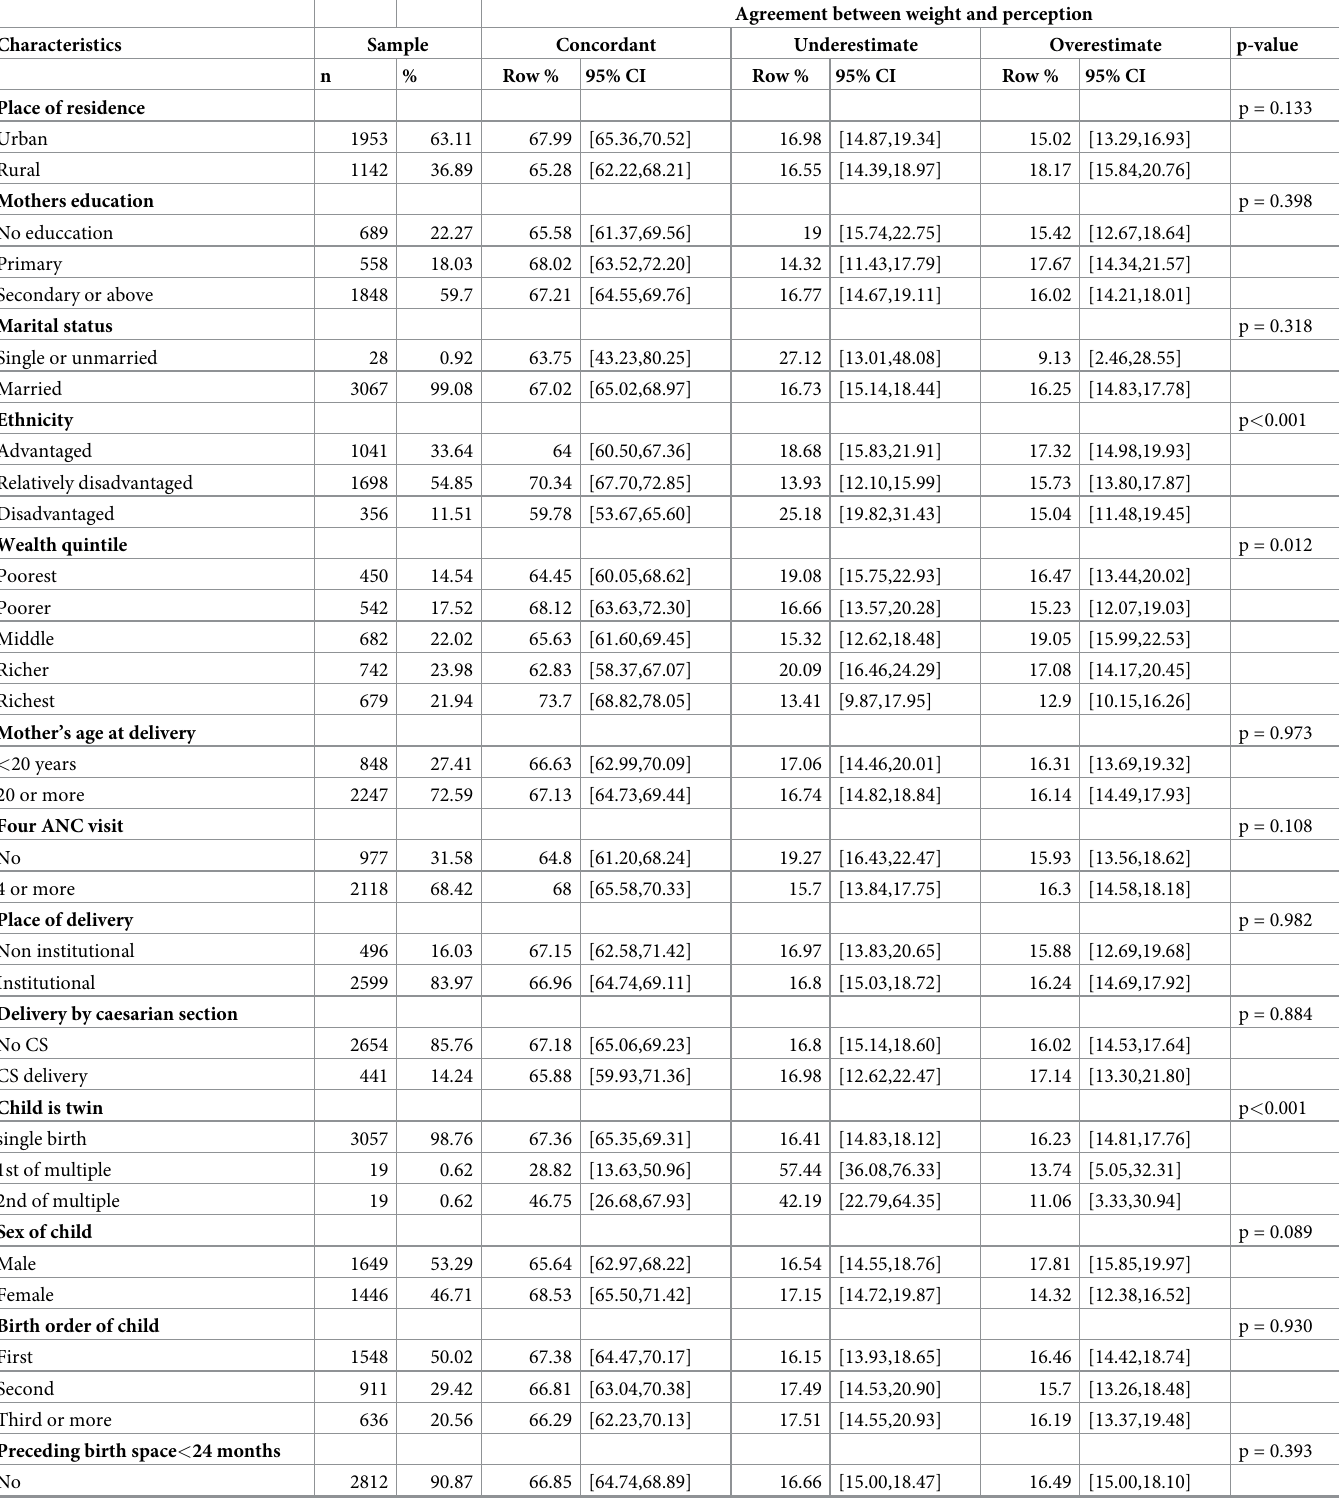
Table 1. Background characteristics of mother and child with non-missing birth weight, NDHS 2016 (n =